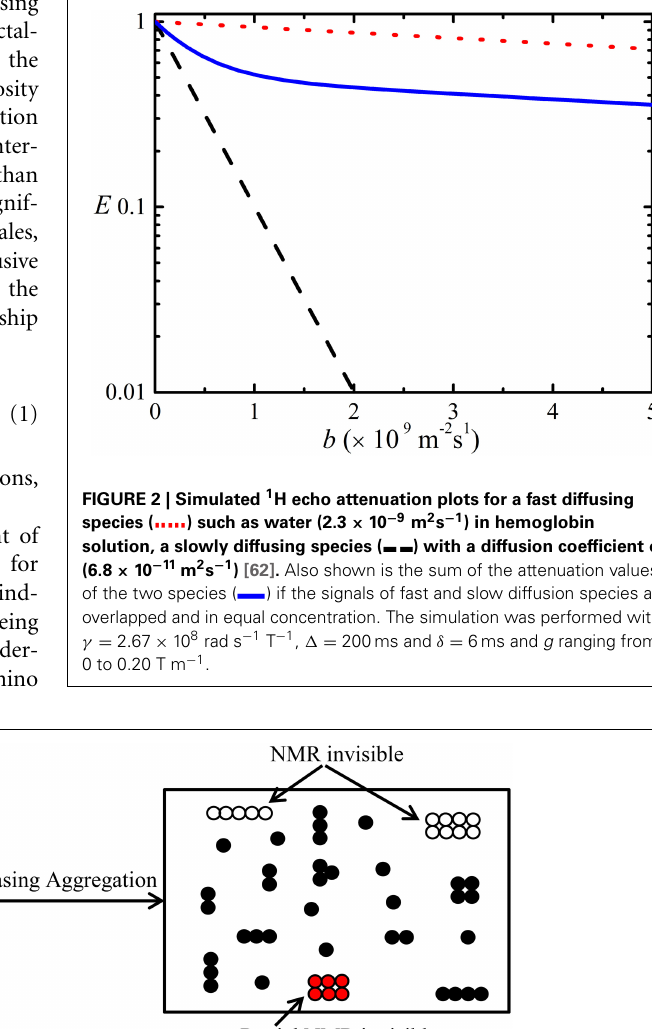
form with increasing concentration. As the oligomeric size increases the T 2 value becomes shorter, consequently according to Equation (4) the oligomer becomes increasingly NMR